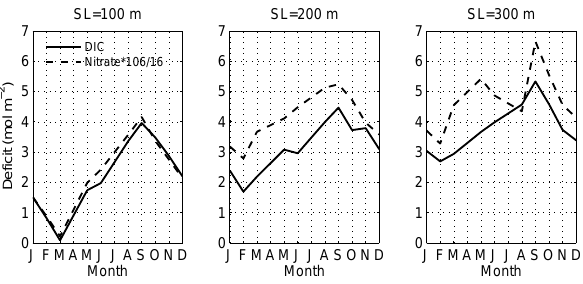
Figure 7. Comparison of calculated monthly-mean deficits of DIC and nitrate in the Iceland Sea, for different thickness of the surface layer (SL). The nitrate deficits are multiplied with the Redfield C : N ratio of